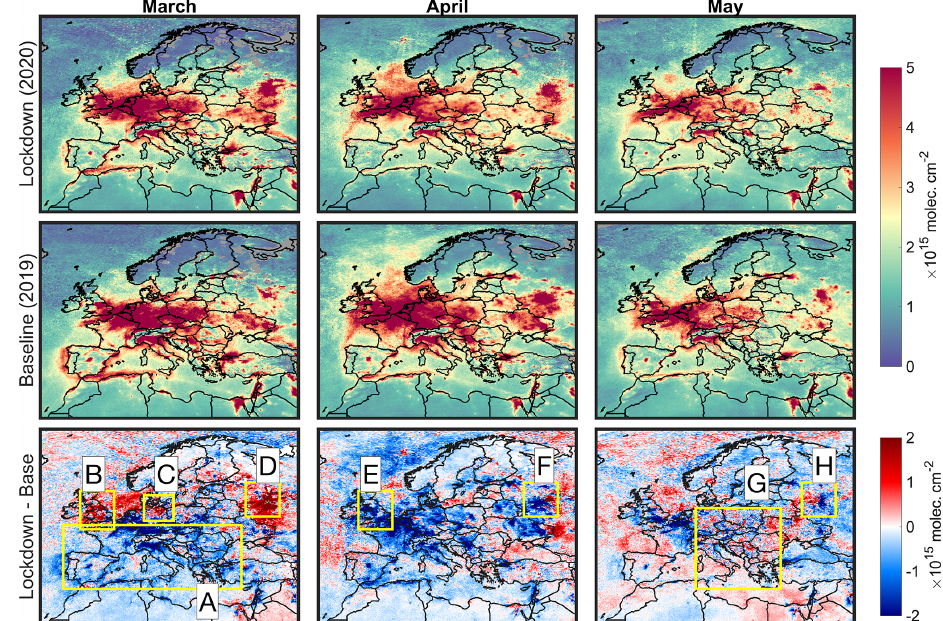
Figure 2. First row: maps of tropospheric NO 2 from the TROPOMI sensor during months of March, April, and May in 2020 (lockdown). Second row: same as the first row but for the baseline year (2019). Last row: difference of the columns in 2020 with respect to those of 2019. All columns are corrected for the bias and their AMFs are recalculated iteratively based on the posterior profiles derived from our inverse modeling practice. The satellite-derived columns are subject to errors, so a direct interpretation of their magnitudes cannot be performed in a robust manner.